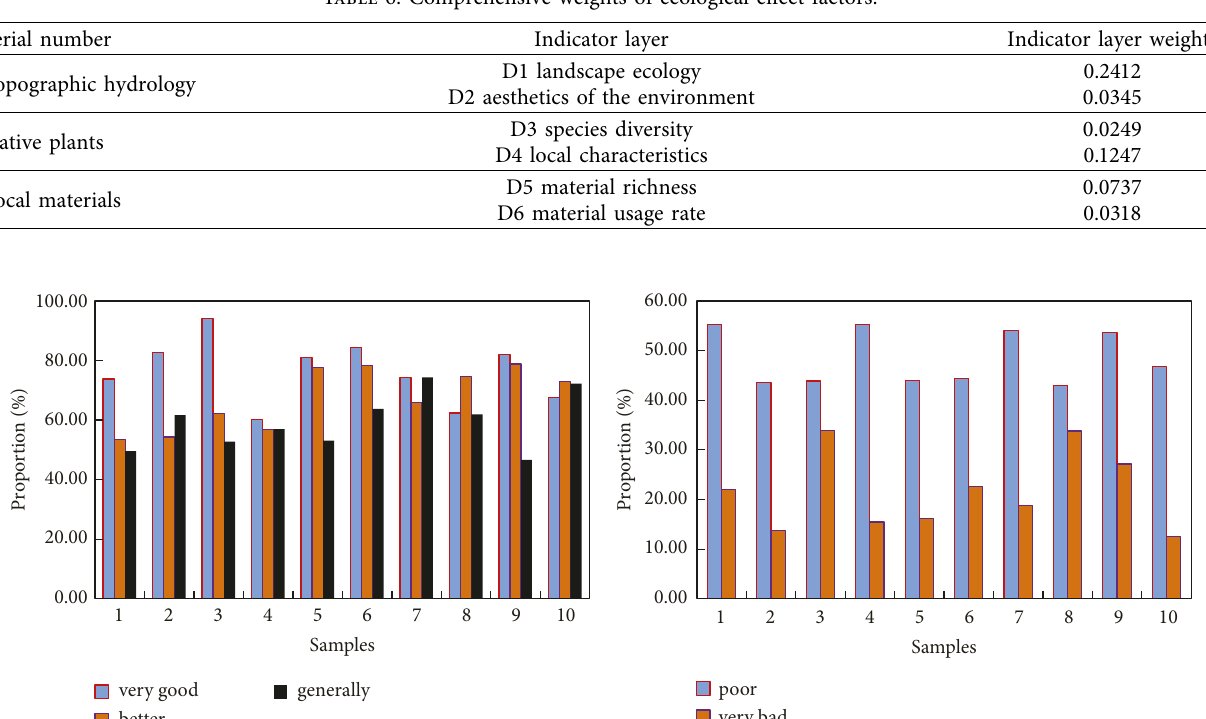
Figure 8: The fit degree of vernacular architecture and the environment is the fit degree evaluation of the